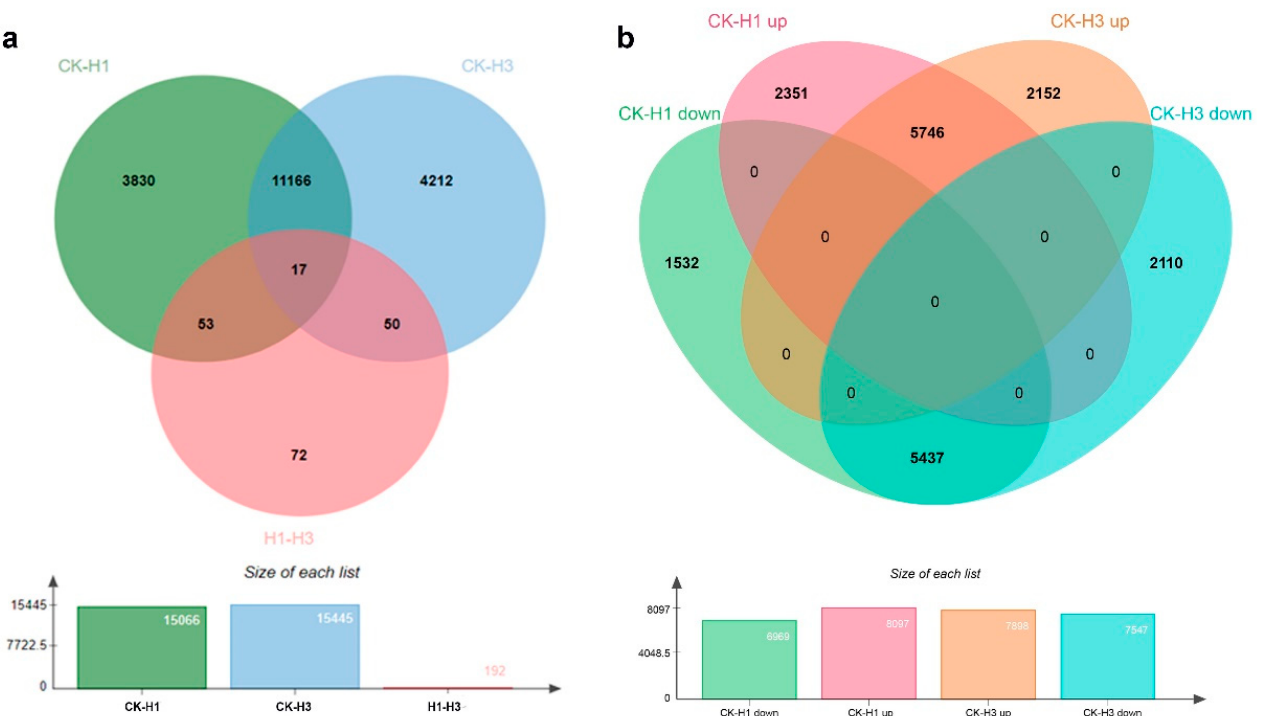
Figure 7. Venn diagram analysis of differentially expressed genes (DEGs). ( a ) Venn diagram showing the overlapping and unique DEGs amongst the comparison groups, ( b ) Venn diagram showing the up-regulated and down-regulated DEGs in CK vs. H1 and CK vs. H3. CK, control group; H1, group with heat stress treatment for 1 d; H3, group with heat stress treatment for 3 d.